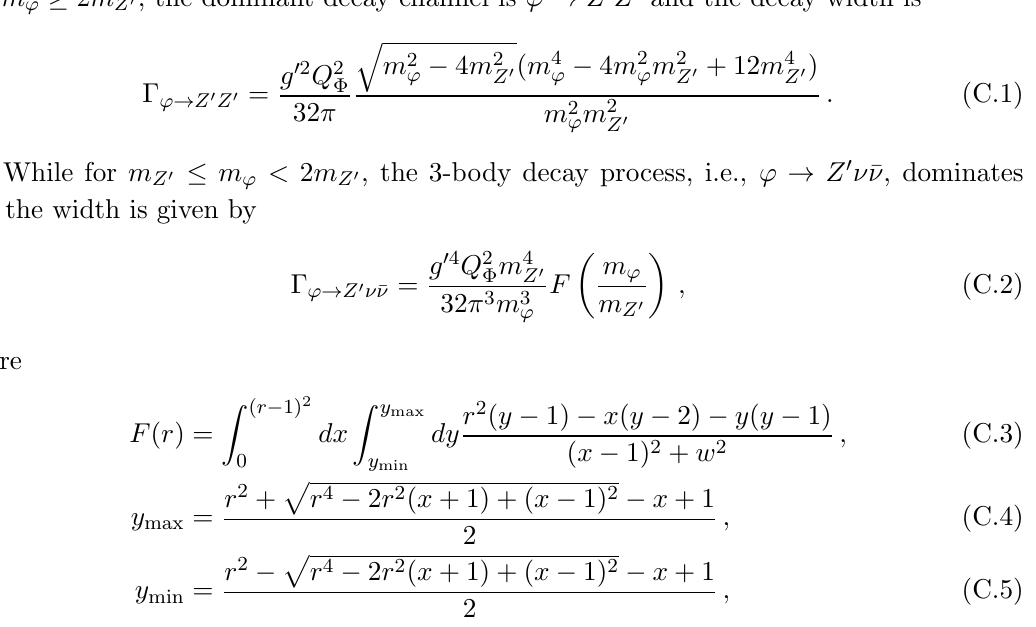
Figure 4 . Left: evolution of T=T (cid:23) (red) and T (dashed). Shown also is the case for the tightly coupled limit, i.e., T = T lifetime of ’ as a function of m ’